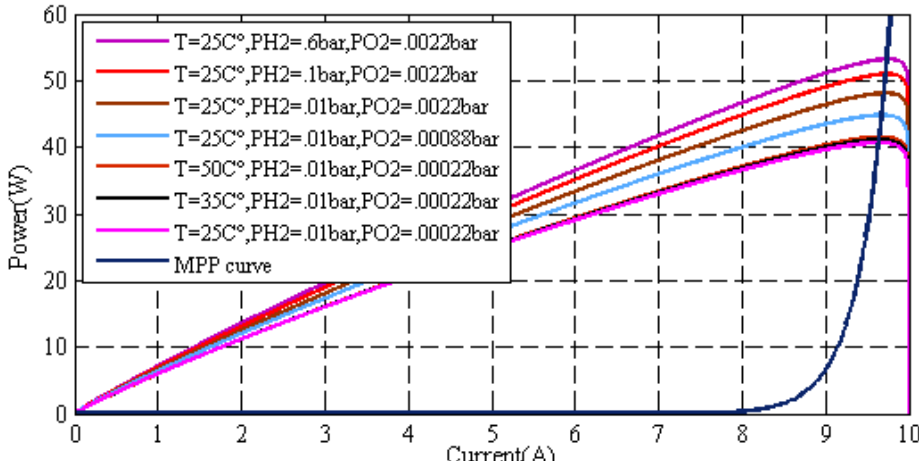
Figure 7. The effect of the operation pressure and temperature on the PI polarization curves.